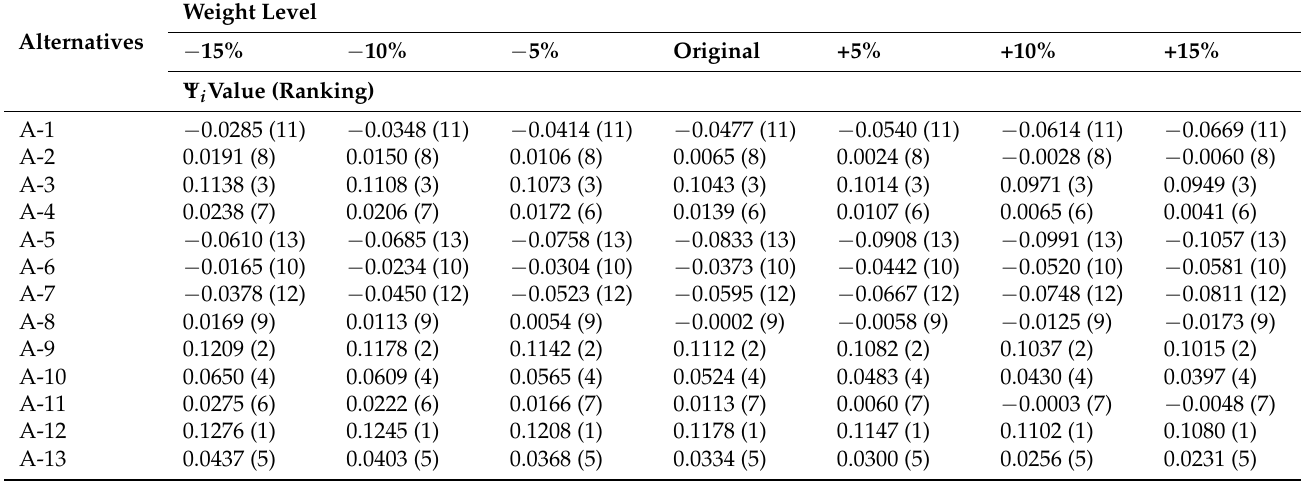
Table 8. Weight sensitivity of C-8 (wear) on